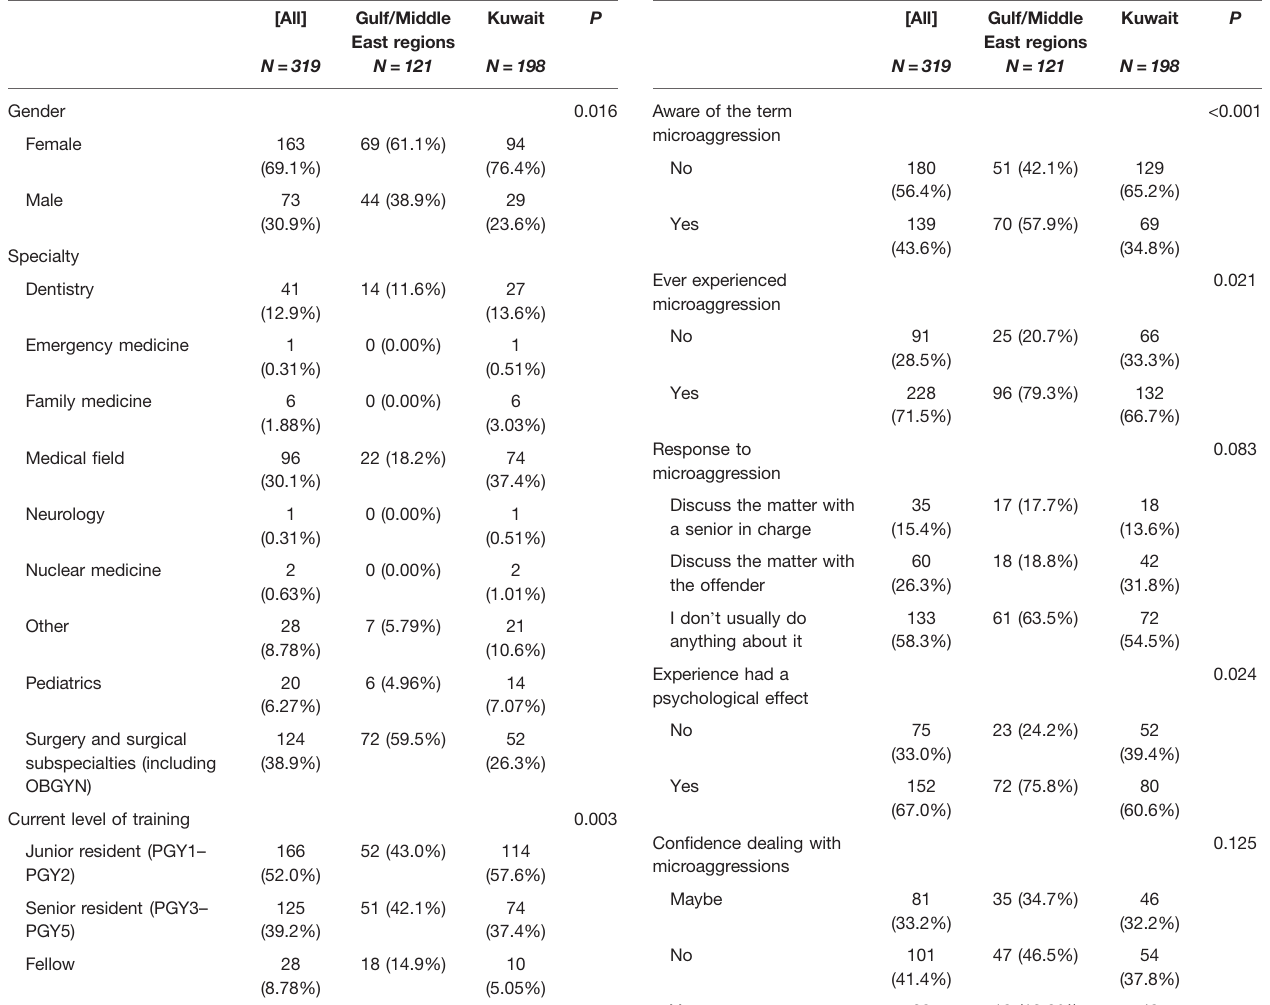
TABLE 1B | Descriptive statistics for the study sample strati fi ed by residency location.